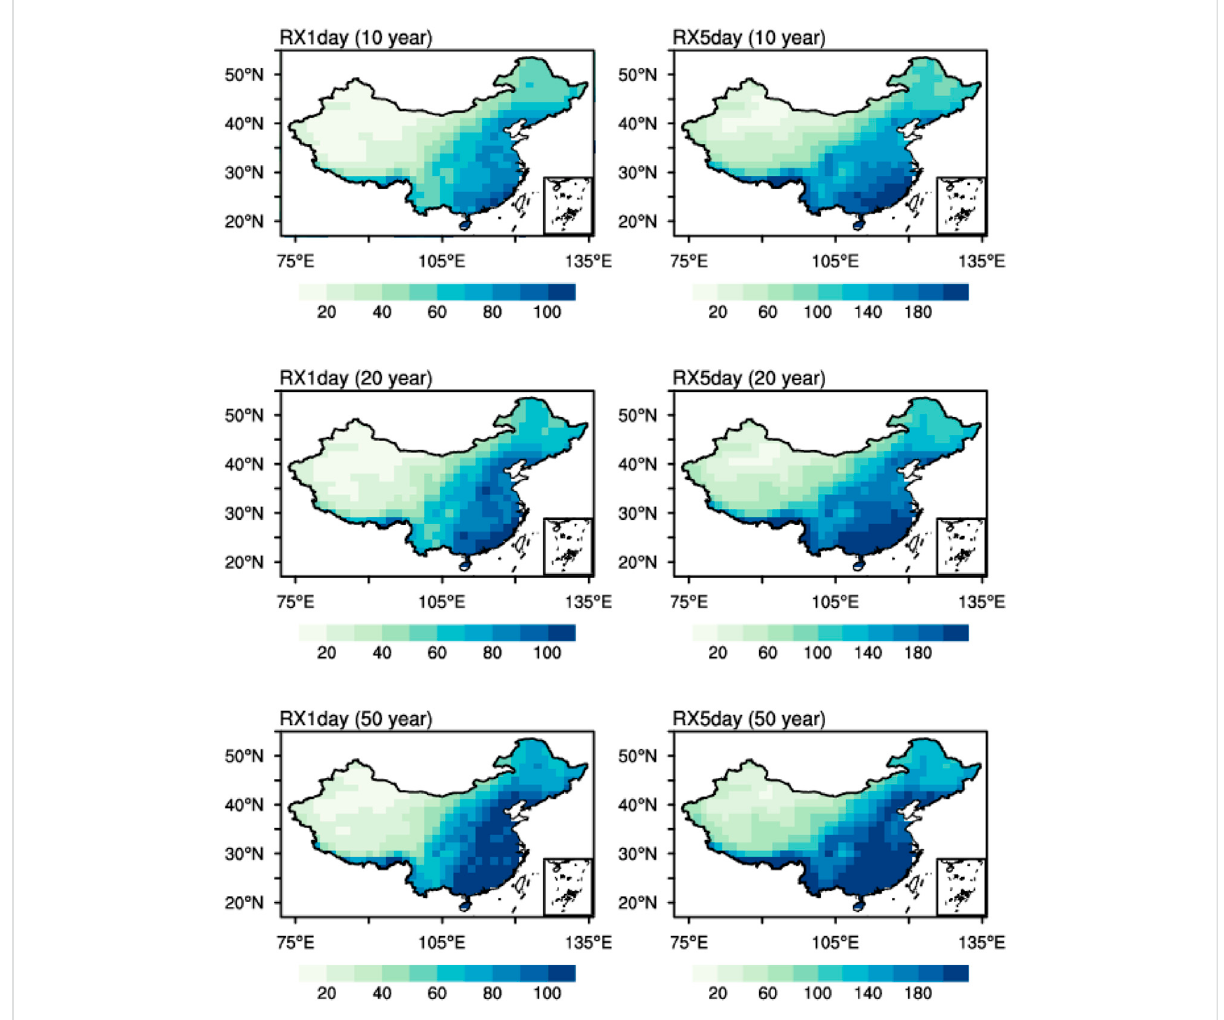
FIGURE 1 Estimated return values for the extreme events (RX1day and RX5day) that occur once in 10, 20, and 50 years fi tted by the GEV analysis for the period of 1950 – 2014. Units: